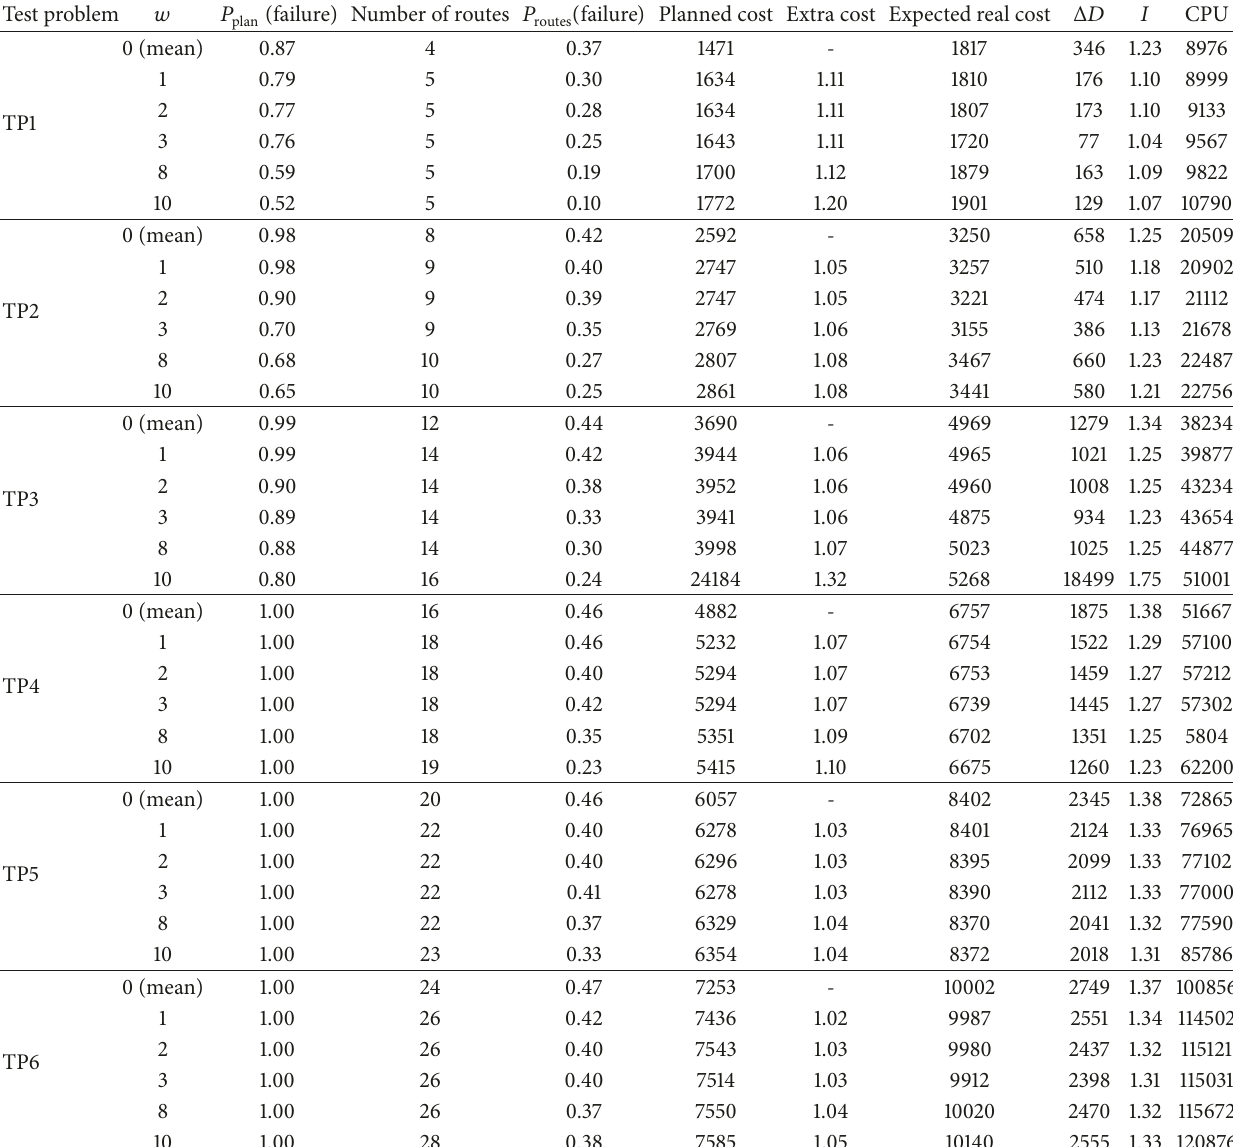
Table 3: Results for the test problems considering the weight 𝑤 . Test